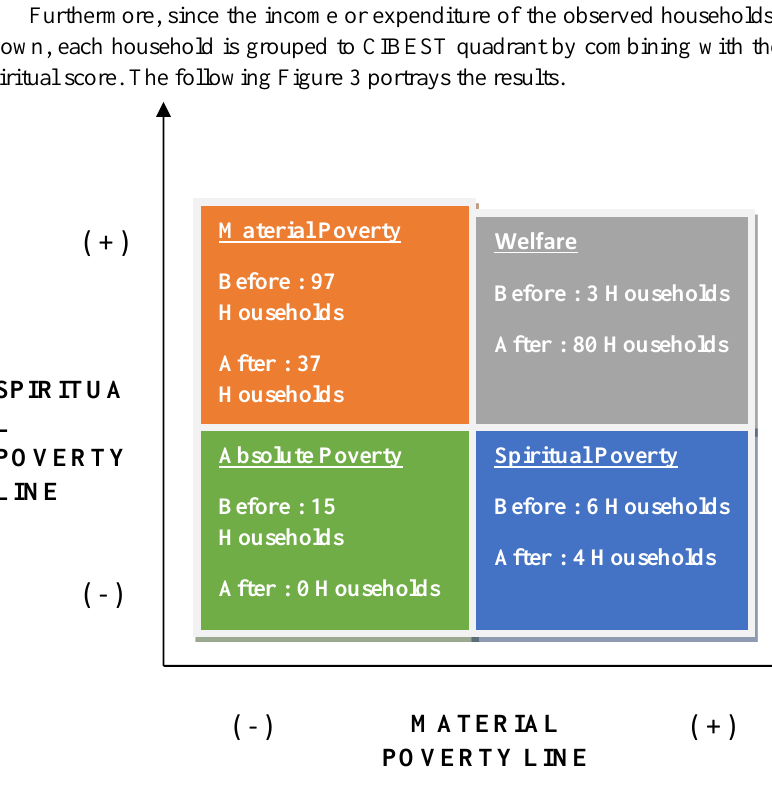
Figure 3 Grouping of Mustahik Based on CIBEST Quadrant (Pre and Post